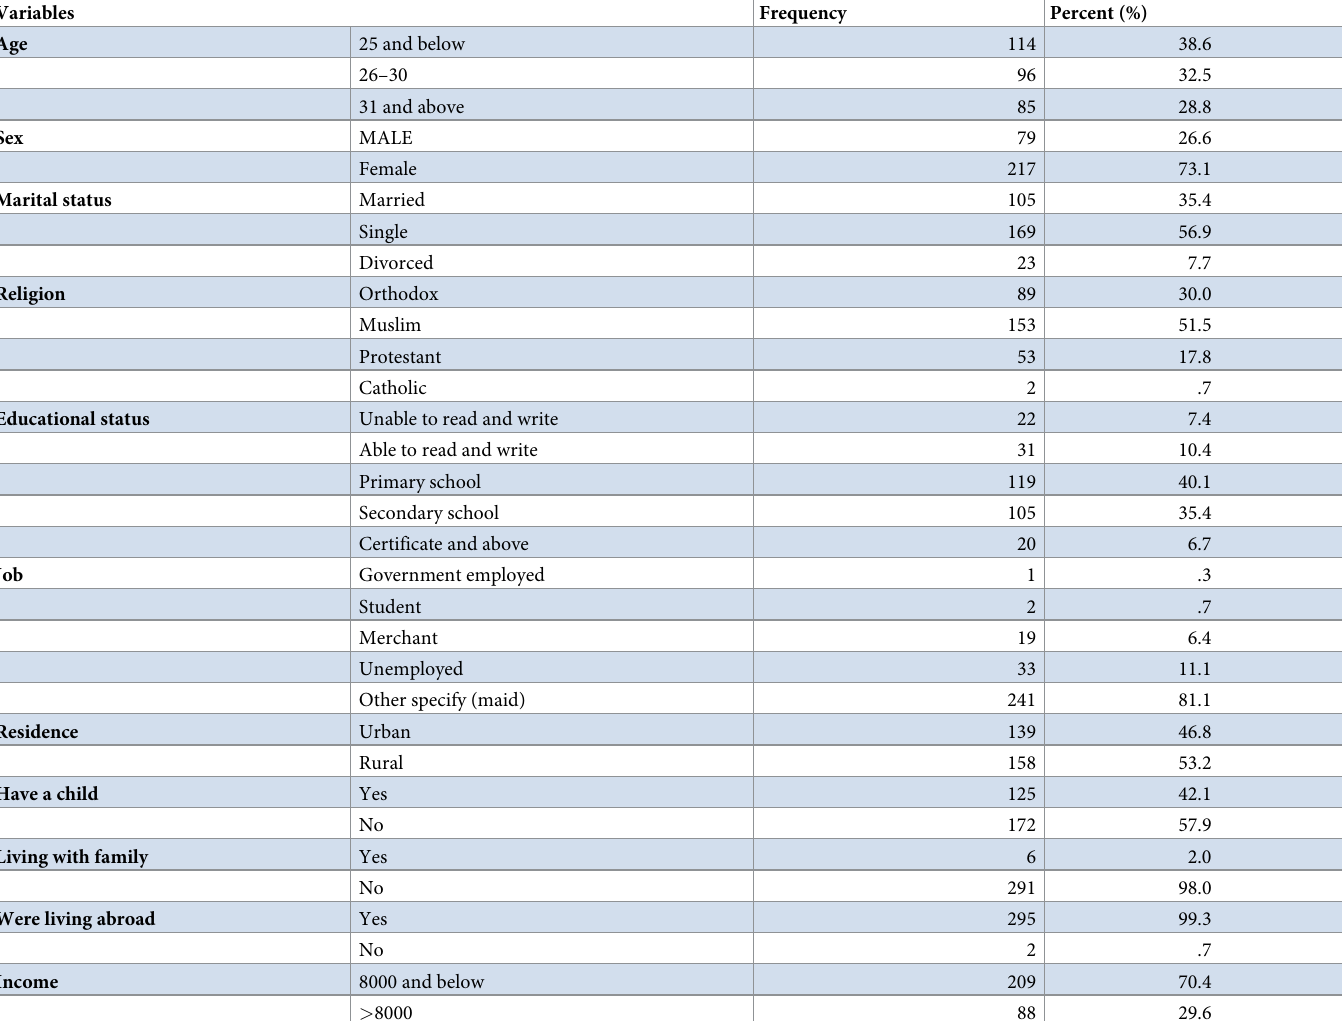
Table 1. Descriptions of socio-demographic factors among individuals under quarantine during the Covid-19 pandemic, in Addis Ababa, Ethiopia, 2020.